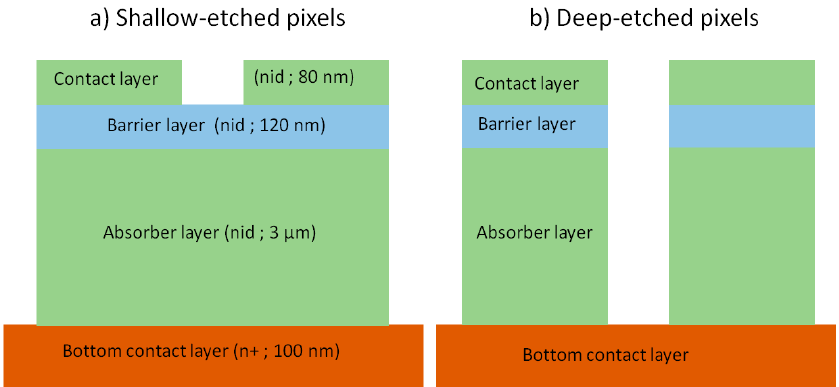
Figure 2. TRPL signal of the Ga-free XBn InAs/InAsSb T2SL structure at 150 K. Following the approach of Donetsky et al. [18], a minority carrier lifetime of 850 ns is extracted from measurement.